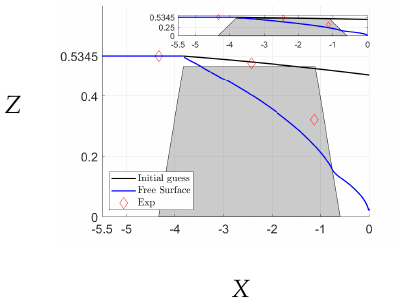
Figure 11. Free surface at flow rate 0.034 m 2